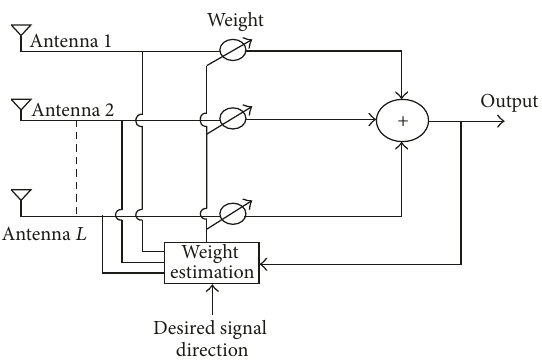
Figure 1: Block diagram of a communication system using an antenna array [1].